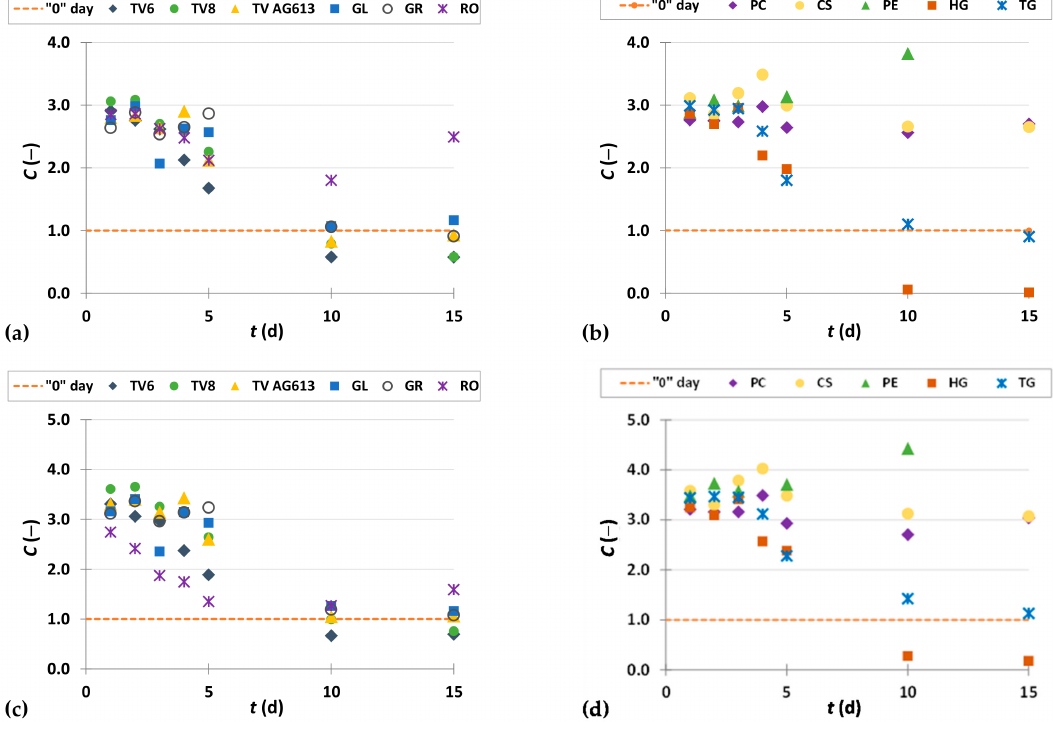
Figure 8. Dimensionless content ( C = C i / C o ) of quercetin ( a , b ) and kaempferol ( c , d ) in GP extracts before biological treatment (‘0’ day) and after 1–15 days of biological treatment with TV6, TV8, TV AG613, GL, GR, RO ( a , c ), and PC, CS, PE, HG, TG ( b , d ).